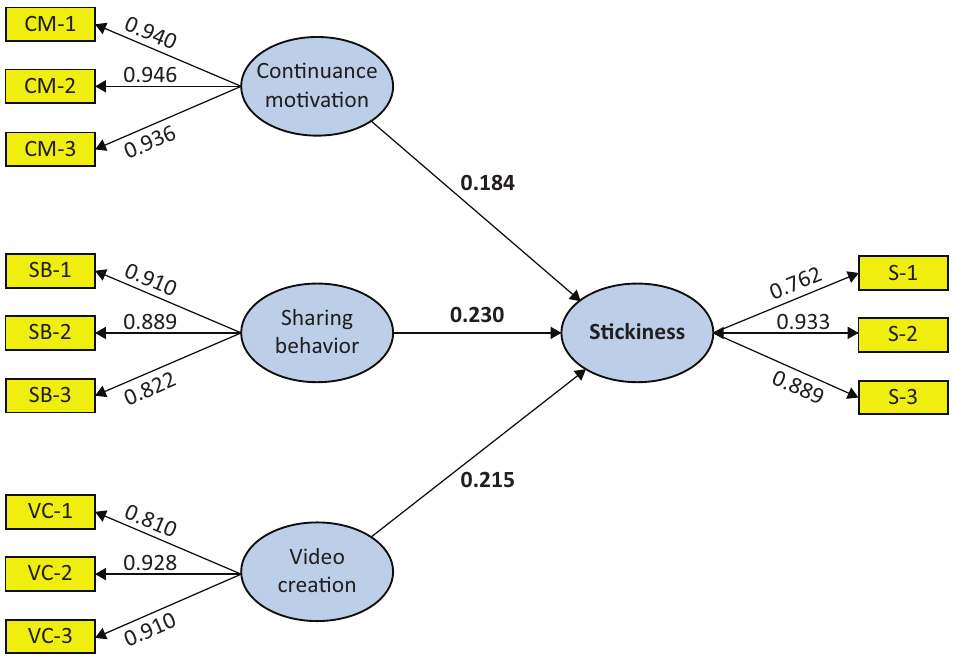
Figure 2. Model result for